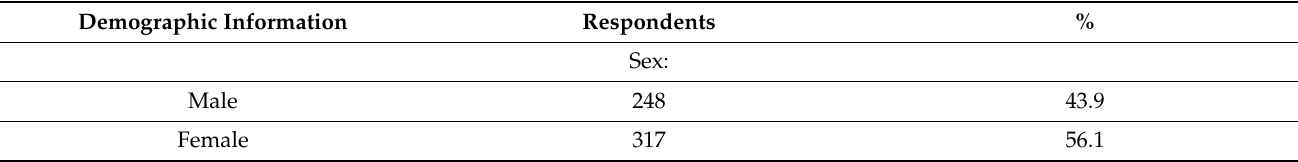
Table A2. Demographic characteristics of the